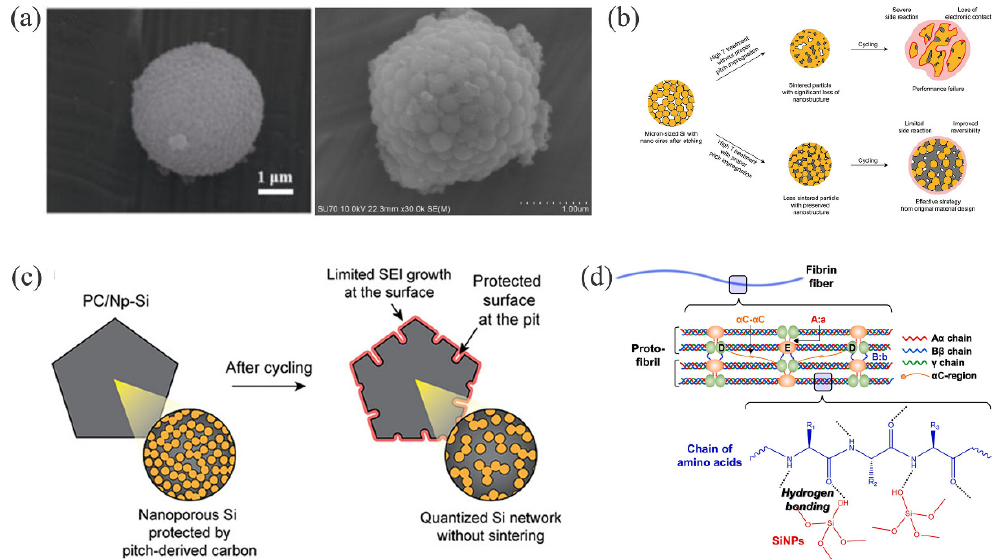
Figure 7. ( a ) SEM images of PSi/C anode materials, before and after deep-cycling [209]. Reprinted with permission from Ref. [209]. Copyright 2021, J. Adv. Ceram. ( b ) Protective mechanism of pitch impregnation on nano-porous silicon structure [74]. Reprinted with permission from Ref. [74]. Copyright 2021, Adv. Mater. ( c ) Structural changes of PC/Np − Si anode before and after cycling [74]. Reprinted with permission from Ref. [74]. Copyright 2021, Adv. Mater. ( d ) Supramolecular interactions between fibrin and silicon [213]. Reprinted with permission from Ref. [213]. Copyright 2021, Appl. Surf. Sci.